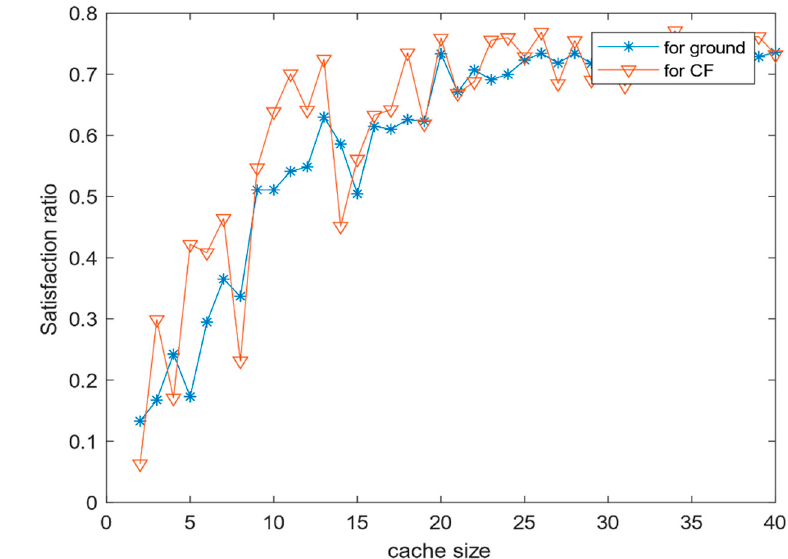
Figure 5. User satisfaction rate versus cache capacity in method 2. Table 2. List of parameters.